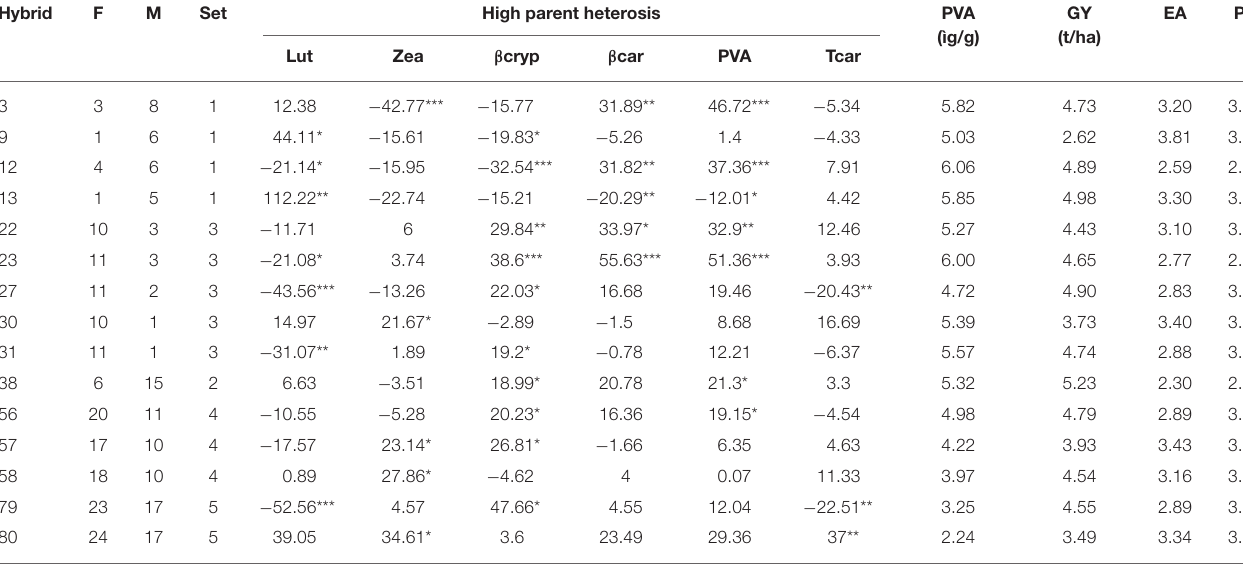
TABLE 8 | High parent heterosis (hPH%) estimates, provitamin A content, and agronomic performances of 15 F1 hybrids, out of the 80 F1 hybrids generated from 24 inbred lines of maize in a factorial mating design.